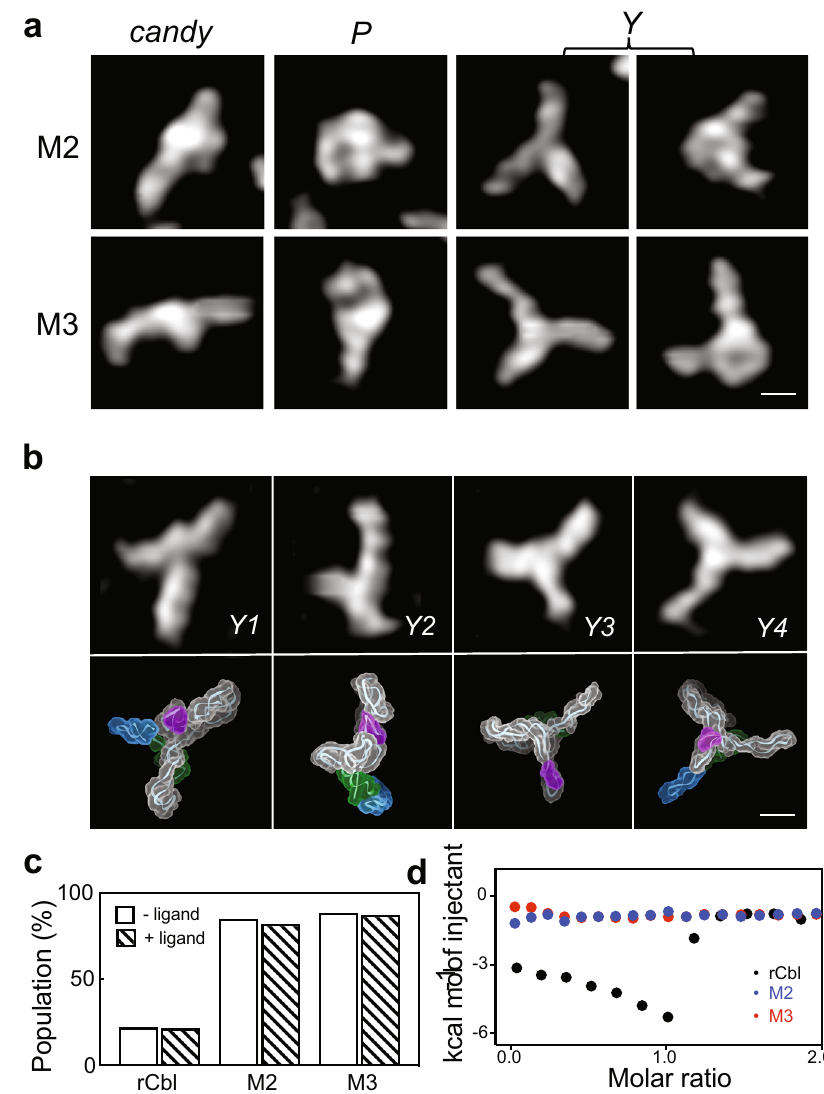
Fig. 4 | Effects ofKL interaction on rCbl folding. a Major conformations for rCbl M2 and M3 mutants in the absence of ligand. Both mutants exhibit dominant (>80%) Y -shaped particles, and minor (<10% each) P - and candy -shaped particles reminiscent of the non-mutant conformations. b AFM images (top) and recapitu- lated structures (bottom) for Y1 and Y2 conformers of rCbl, and Y3 and Y4 con- formers of M2 and M3 mutants, respectively. P1, P5, and P13 helices are colored in green, purple and blue, respectively. Scale bars of 5nm are shown in the right bottom corner for ( a ) and ( b ). c Population tallies of Y conformers in the rCbl, M2 andM3samplesintheabsenceorpresenceofligand.Inallcases,the Y populationis